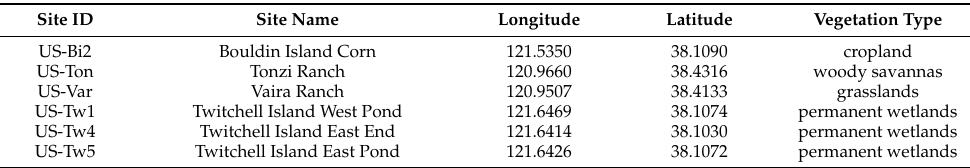
Table 1. AmeriFlux eddy covariance sites used in this paper